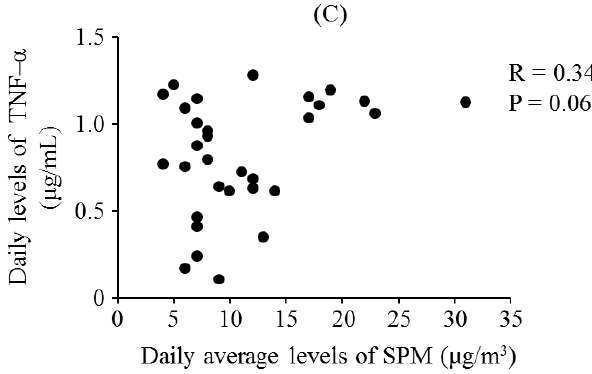
Figure 3. Associations between the daily levels of suspended particulate matter (SPM) and ( A ) interleukin (IL)-6; ( B ) IL-8; ( C ) tumor necrosis factor (TNF)-α.